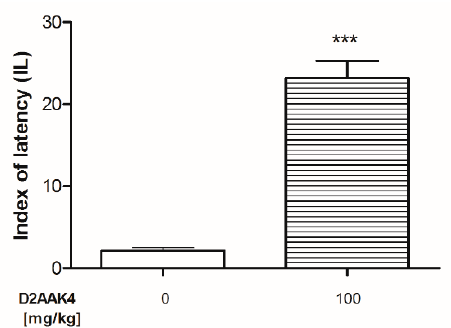
Figure 9. Acute effect of D2AAK4 on memory consolidation in mice evaluated in passive avoidance (PA) test. Appropriate groups of mice were injected D2AAK4 (100 mg/kg (n = 8); i.p.) and vehicle ((n = 8, indicated as 0); i.p.) on Day 1 immediately after the PA test, and 24 h later (i.e., on Day 2), these mice were retested as previously described in [12]. Data are presented as mean ± SEM. The results from the t-test analyses indicate: *** p < 0.0001 when compared with the vehicle-treated group.